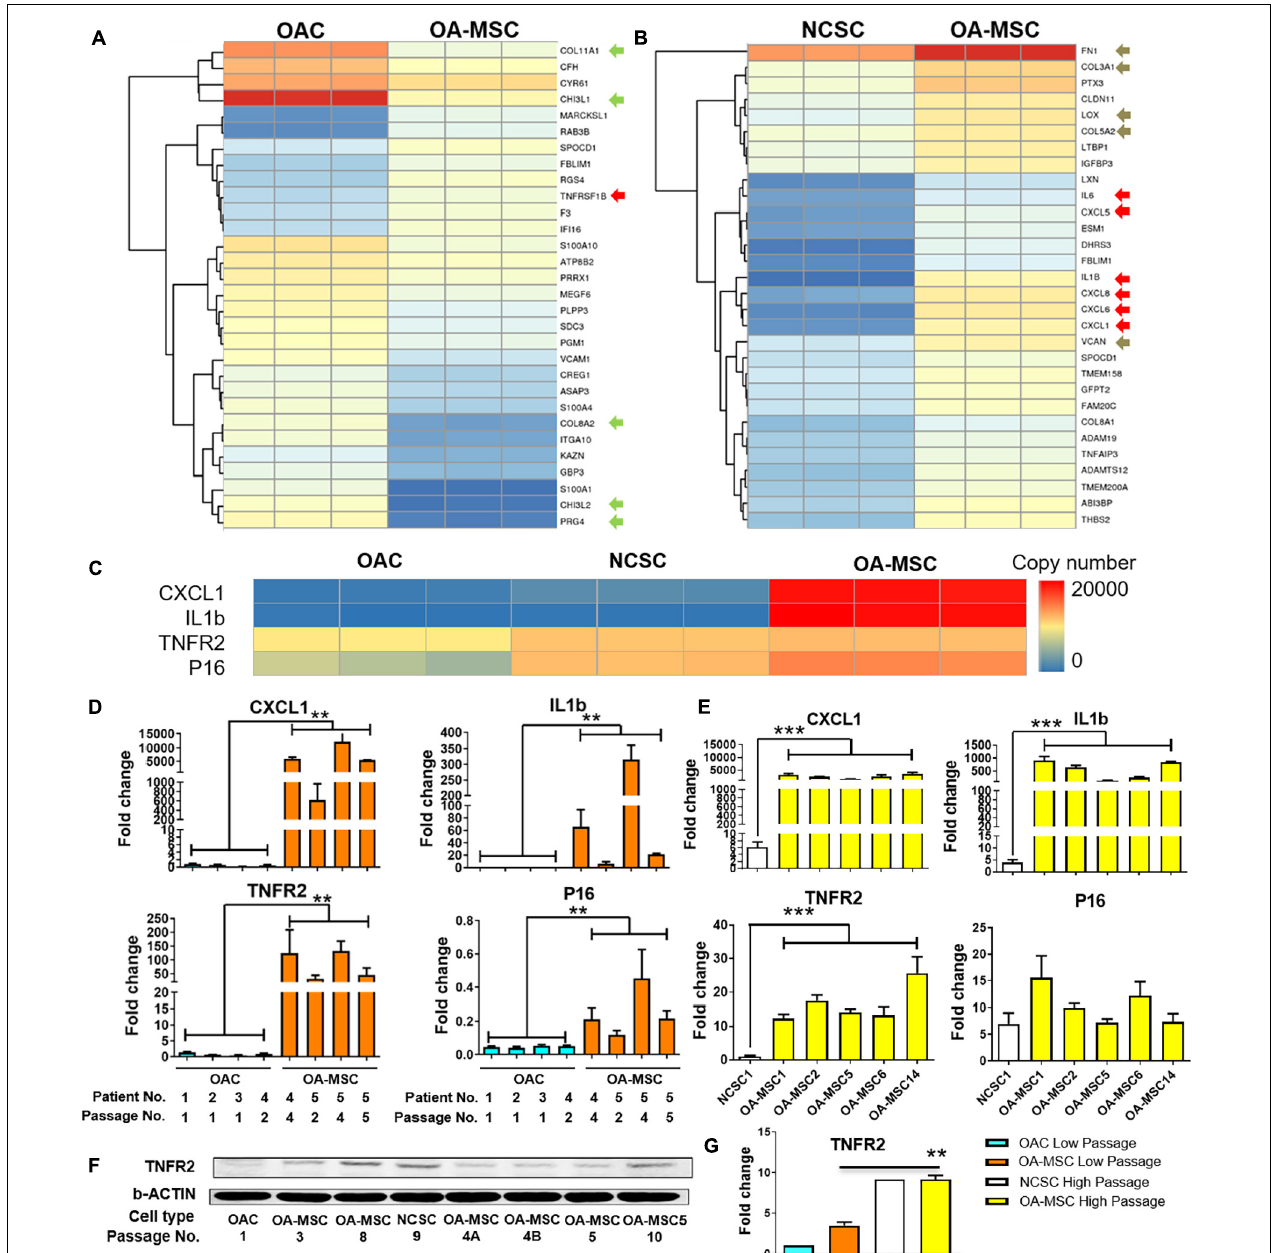
FIGURE 2 | Differential gene expression analysis by RNA sequencing and validation by real-time PCR and western blot analysis. Heatmap of hierarchical clustering of top 30 most significant differentially expressed genes in OA-MSC vs. OAC (A) , and NCSC (B) . RNAseq data of OA-MSC2 and NCSC3 were utilized ( p < 0.05). Green arrows: chondrogenic genes; red arrows: cytokine genes; brown arrows: fibrosis genes. (C) Heatmap of a group of highly expressed genes in OA-MSC in comparison to OAC and NCSC. The normalized transcript copy number of each gene was shown in triplicated RNA samples. RNAseq data of OA-MSC2 and NCSC3 were utilized ( p < 0.05). Validation of RNAseq data by real-time RT-PCR analysis of the group of four highly expressed genes in OA-MSC (D,E) . (D) RNA samples were isolated from primary human OA articular cartilage cell cultures (OAC and OA-MSC) at different cell passages as indicated. The information of five OA patients is as follows. Patient 1: Female, Age 56 years; Patient 2: Female, Age 75 years; Patient 3: Female, Age 85 years; Patient 4: Female, Age 73 years; Patient 5: Male, Age 66 years. The value of each RNA sample group = mean ± SD. N = 3 for all groups. ** p -value < 0.01. (E) RNA samples were isolated from cell culture of NCSC and OA-MSC cell lines. Real-time RT-PCR data of NCSC1 and five OA-MSC cell lines were utilized as indicated. The value of each RNA sample group = mean ± SD. N = 3 for all groups. *** p -value < 0.001. (F) Western Blot analysis of TNFR2 protein expression in OAC, OA-MSC and various NCSC and OA-MSC cell lines at different cell culture passages as indicated. The data shown is representative of three separate analyses. (G) Quantification of western blot analysis of TNFR2 protein levels in OAC, NCSC, and OA-MSC in low and high passage cell culture. The pixels of TNFR2/b-ACTIN were measured by software Image-Pro Plus. The relative TNFR2 protein expression level of OAC Lower Passage was set as 1. T -test was used for statistical analysis between OA-MSC Low Passage group and OA-MSC High Passage group. ** p -value < 0.01.